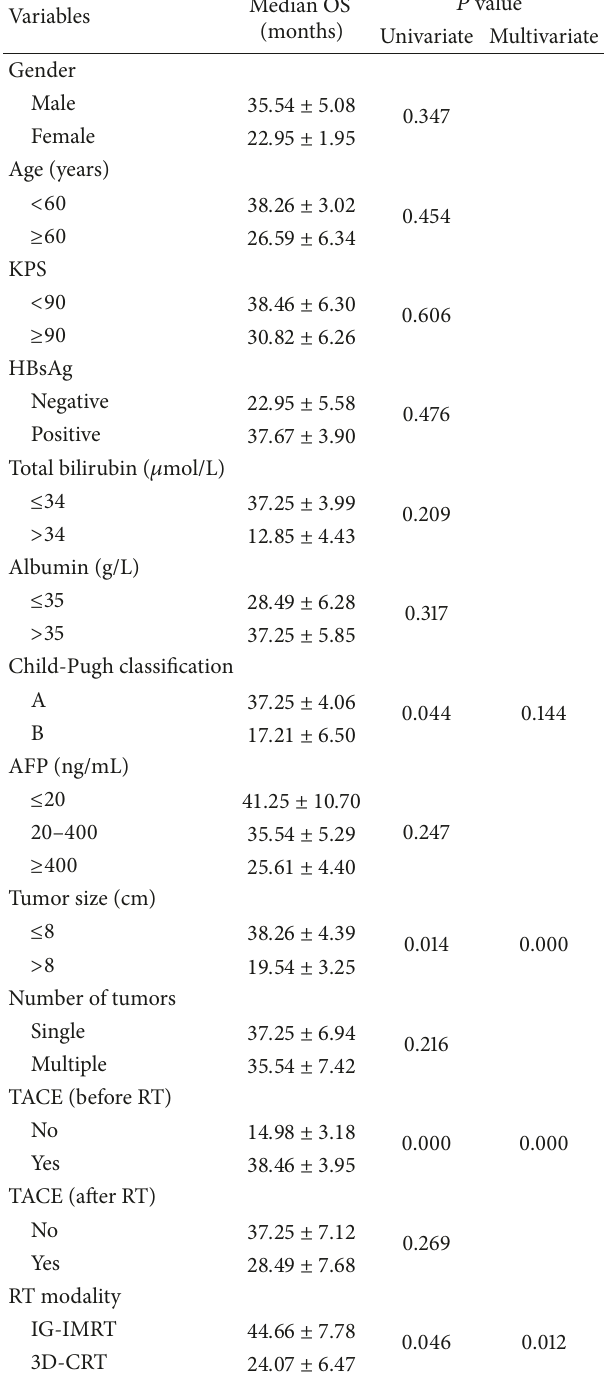
Table 3: Univariate and multivariate analysis of